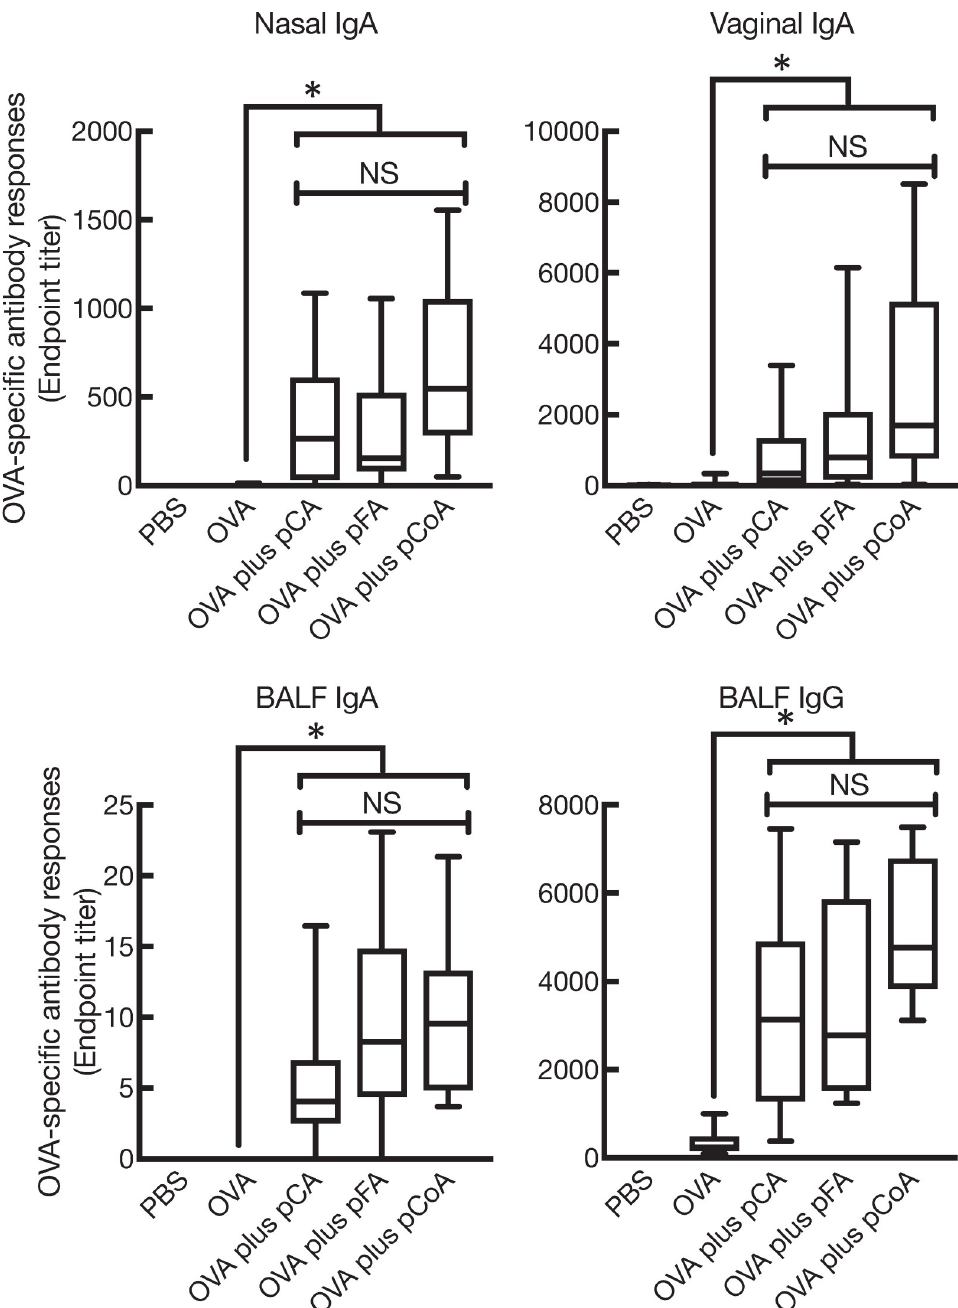
Fig 2. Enzymatically polymerised polyphenols promote antigen-specific mucosal antibody responses. Female BALB/ cCrSlc mice were immunised three times intranasally (days 0, 7, and 14) with vehicle (PBS), OVA (2.5 μ g/mouse) alone, OVA (2.5 μ g/mouse) plus pCA (100 μ g/mouse), OVA (2.5 μ g/mouse) plus pFA (100 μ g/mouse), or OVA (2.5 μ g/mouse) plus pCoA (100 μ g/mouse). OVA-specific IgA endpoint titres in nasal wash, BALF, and vaginal wash as well as OVA- specific IgG endpoint titres in BALF at day 21 were detected by ELISA. The data were obtained from three biologically independent experiments. PBS, n = 9; OVA, n = 9; OVA plus pCA, n = 9; OVA plus pFA, n = 9; OVA plus pCoA, n = 9. The box-plot shows the median value with the 25th–75th percentiles and the error bars indicate the 5th–95th percentiles. Significance was calculated using the Kruskal-Wallis with Dunn’s post-hoc test: � p < 0.05.